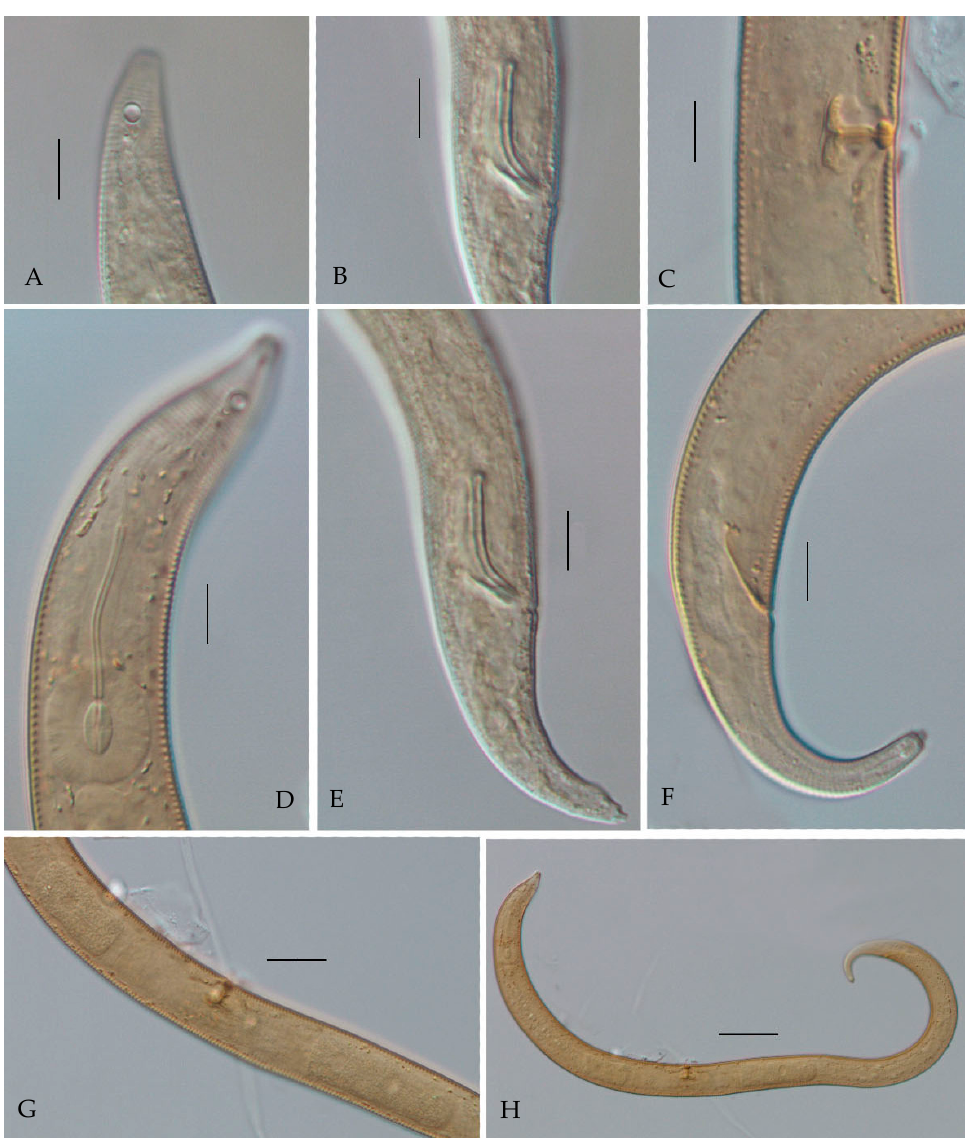
Figure 4. Haliplectus futianisus sp. nov. ( A ) lateral view of male head end showing amphidial fovea; ( B ) lateral view of male copulatory apparatus; ( C ) lateral view of female vulva; ( D ) lateral view of female head end showing pharynx basal bulb; ( E ) lateral view of male tail region; ( F ) lateral view of female tail region; ( G ) lateral view of female body part showing ovaries; ( H ) lateral view of female total body. Scale bars: ( A – F ) = 10 µm; ( G ) = 25µm; ( H ) = 50 µm.